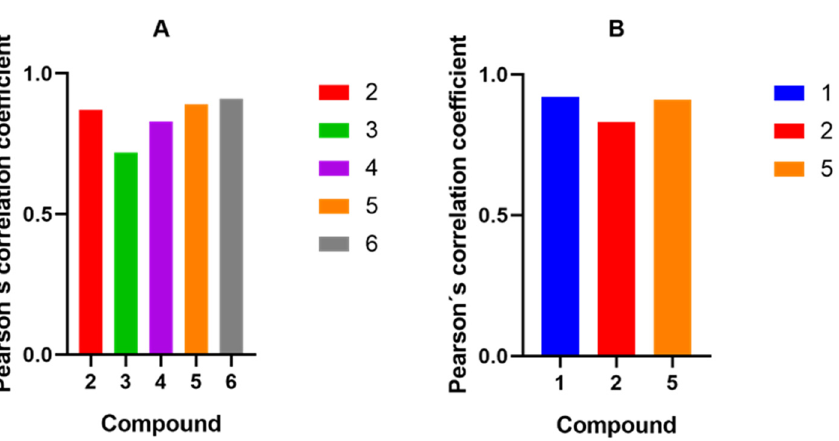
Figure 11. Graphs of Pearson’s correlation coefficients for compounds 1 – 6 with either LysoTracker ® Green FM ( A ) or MitoTracker ® Red FM ( B ).